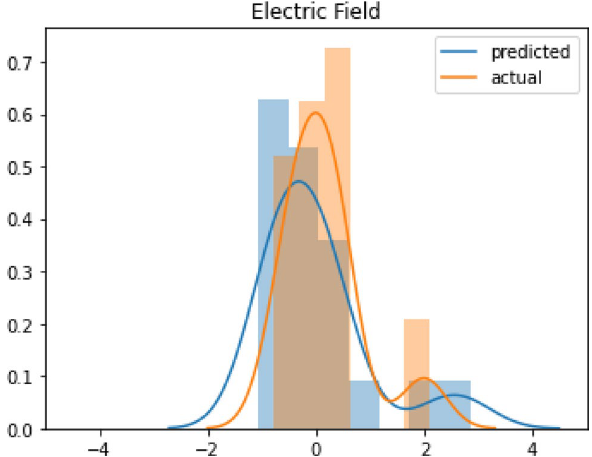
Figure 6. KDE probability density curve of the electric field: actual vs. predicted.